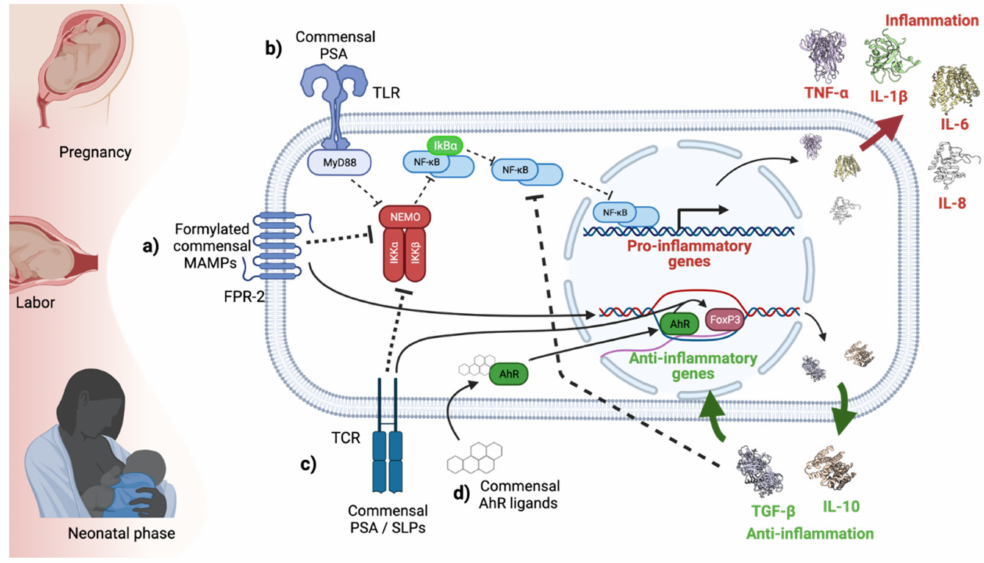
Figure 2. Effects of exposure to microbiota-derived metabolites. ( a ) Commensal formylated MAMPs recognized by the FPR-2 can inhibit the NFkB pathway, downregulating the production of inflamma- tory cytokines such as TNF- α , IL-1 β , IL-6, and IL-8. These MAMPs can also induce the production of anti-inflammatory cytokines such as IL-10 and TGF- β . ( b ) Commensal PSA can inhibit intesti- nal inflammation by the TLR2 pathway in intestinal epithelial cells or the TCR pathway in T cells. ( c ) Commensal PSA and SLPs can stimulate T cell FOXP3 expression, promoting their polariza- tion to Tregs and the production of anti-inflammatory cytokines. ( d ) Commensal AhR ligands can also modulate inflammation by regulating FOXP3-related gene expression directly. Created with